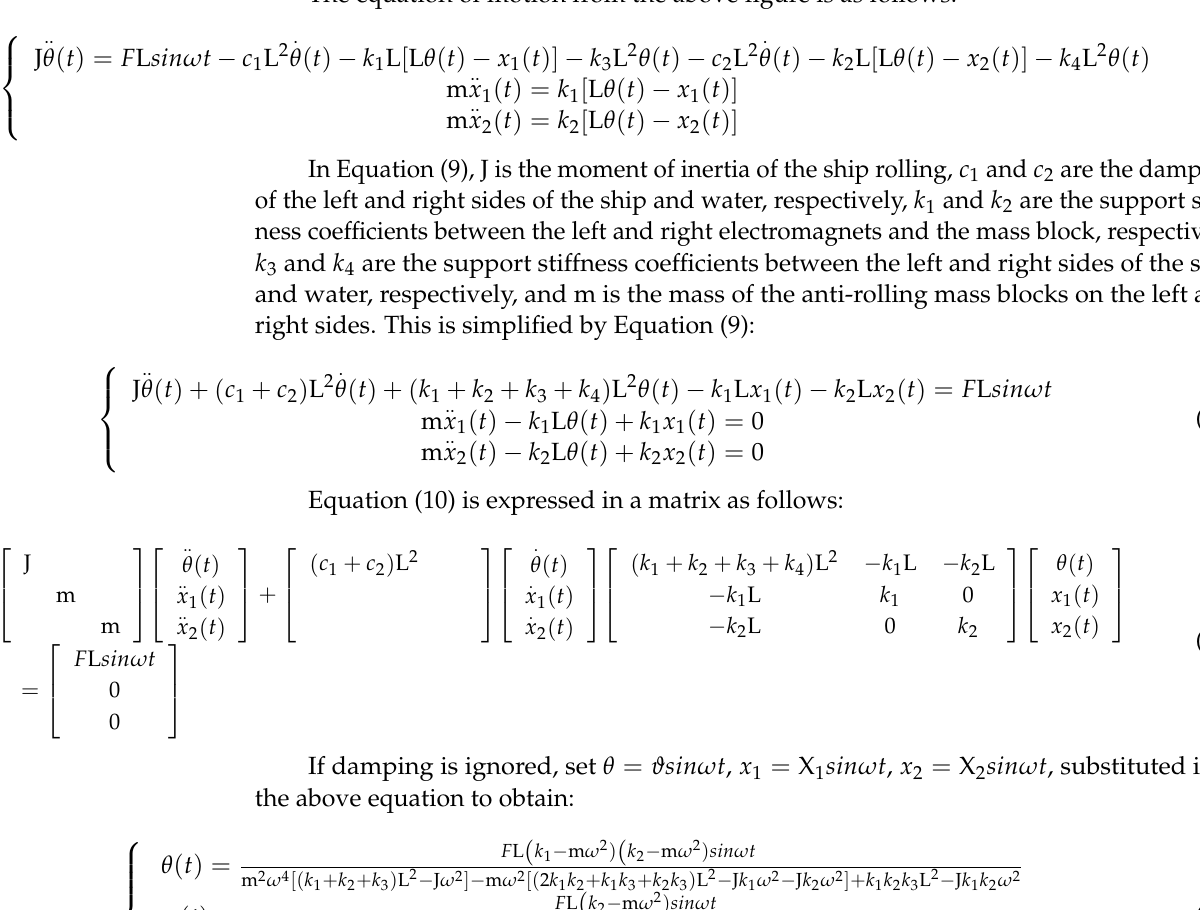
Figure 6. Anti-rolling mass block and ship overall model diagram. ( a ) Schematic diagram of ship cross section;( b ) ship mechanical model.